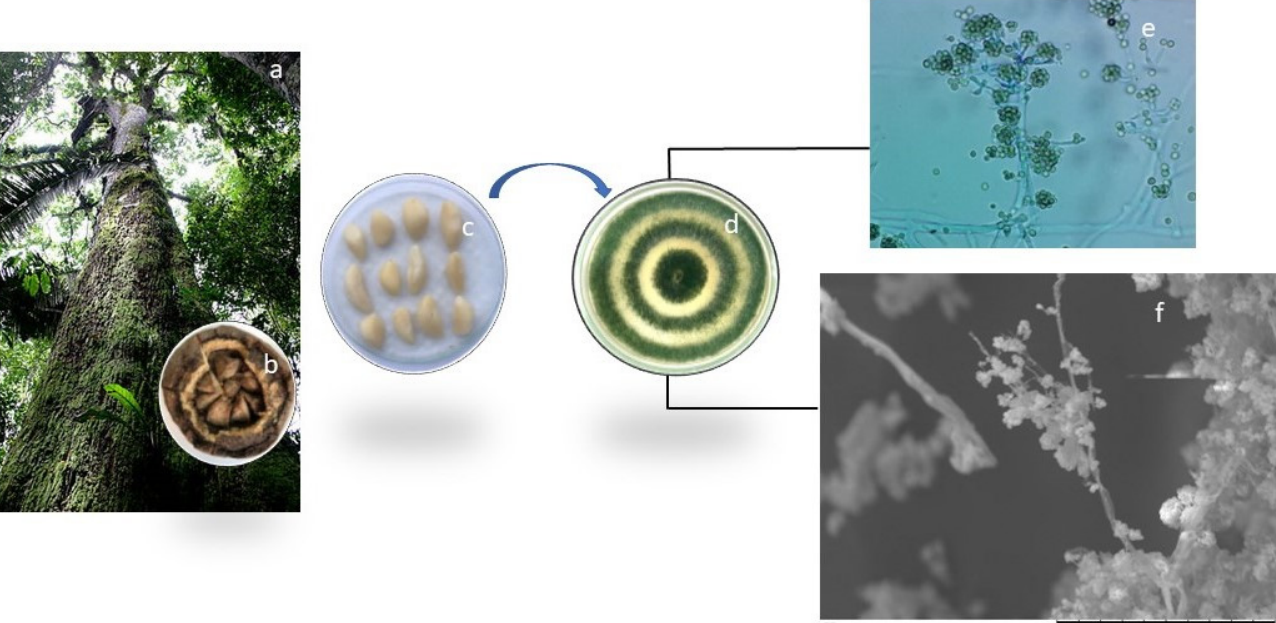
Figure 1. Tree of the species Bertholletia excelsa ( a ), hedgehog ( b ), and almonds ( c ), Morphological identification of the endophytic fungus Trichoderma asperellum cultivated in solid medium ( d ) with microculture observed by optical microscopy ( e ) and microstructural image by Microscopy Scanning Electronics (SEM) at 800× ( f ).